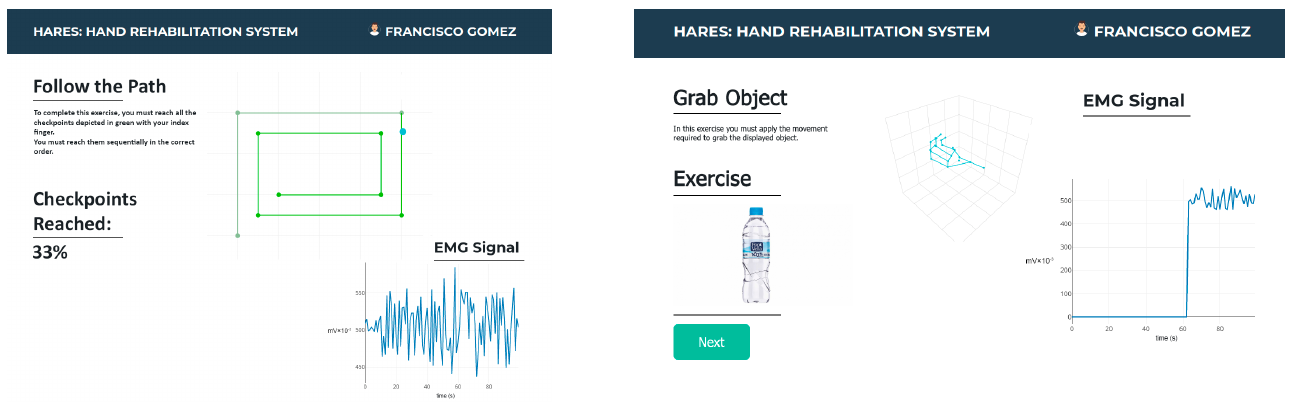
Figure 5. HaReS screenshots that correspond to a follow the path exercise (leftmost) and a grab object